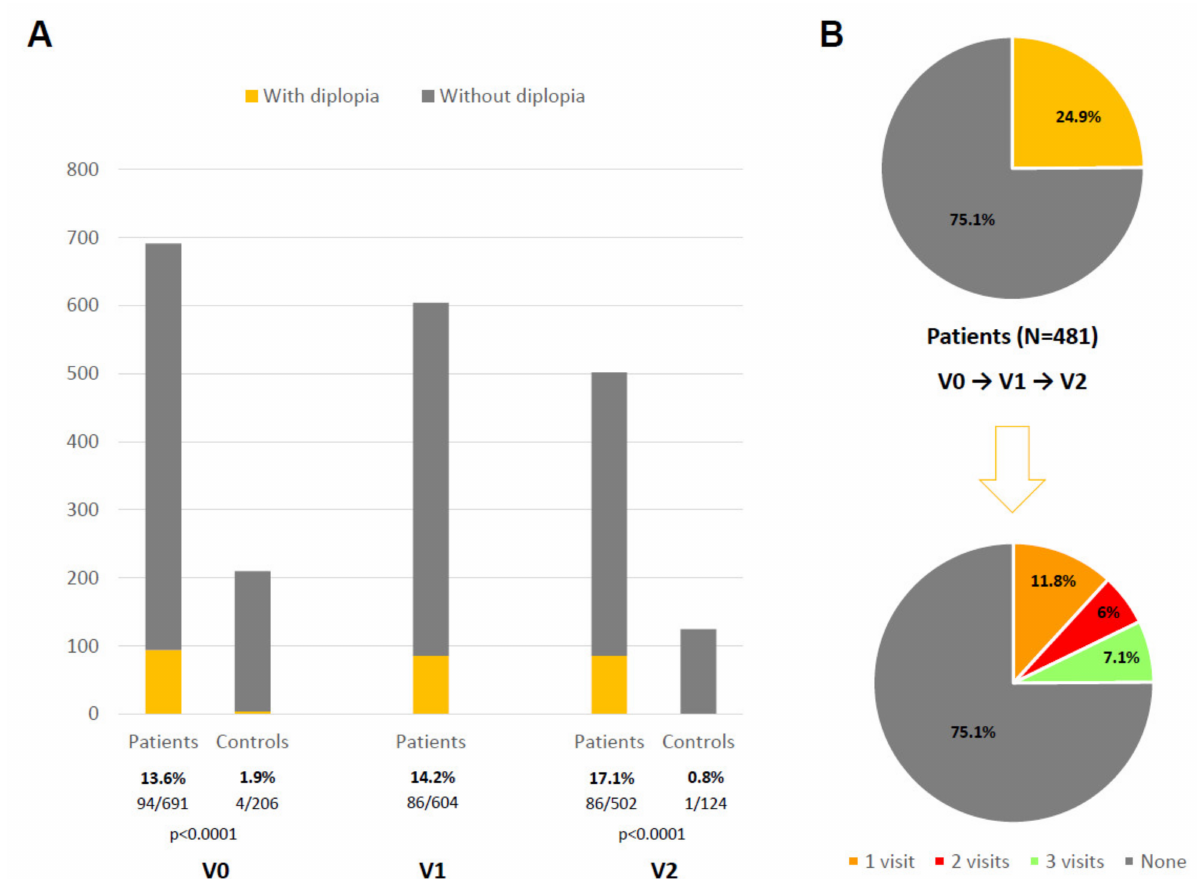
Figure 1. ( A ) Percentage of patients and controls reporting diplopia at different visits: V0, V1, V2. ( B ) Prevalence of diplopia during the follow-up period in all patients who completed the three visits (N = 481; V1, V2, V3) and percentage of cases presenting diplopia in only 1 visit, 2 visits, and all